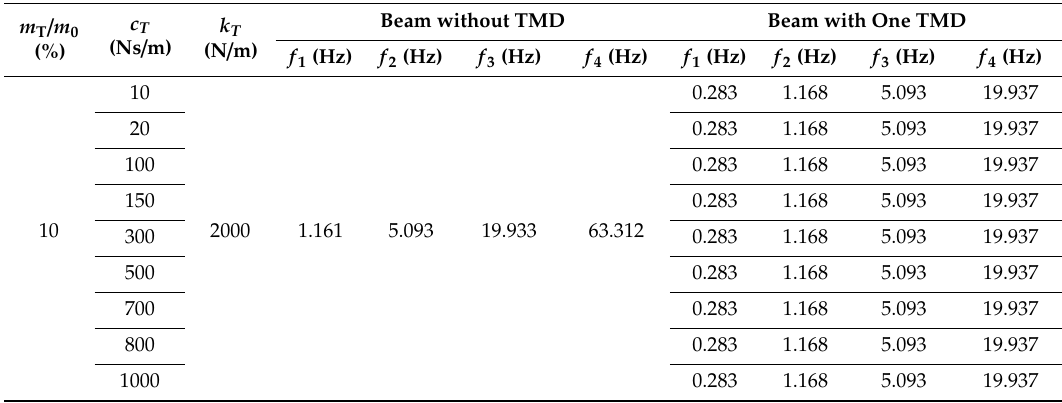
Table 2. Variation of the first natural frequencies as a function of c T.